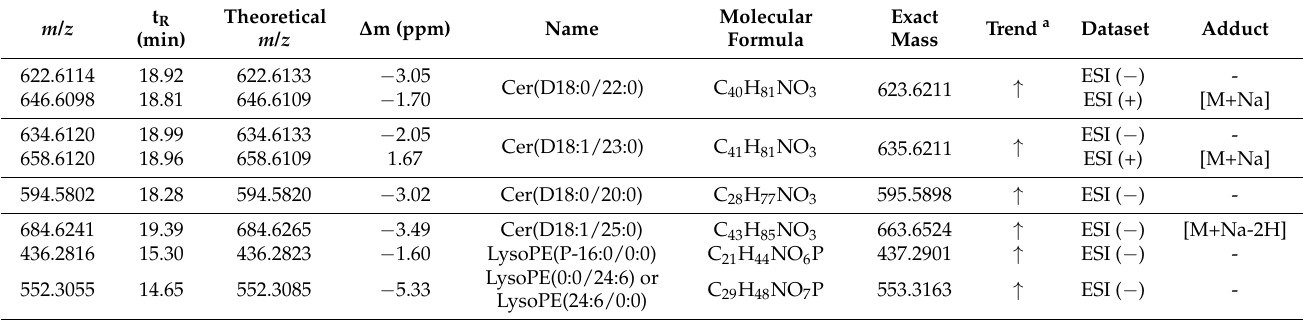
Table 3. Candidate metabolites identified in low and high responders from the plasma-based metabolomic approach obtained from both (+) and ( − ) ESI analyses. The features are presented as a. m / z feature, b. t R (min), c. theoretical m / z , d. ∆ m (ppm), e. possible identification name, f. possible molecular formula, g. corresponding monoisotopic exact mass, h. trend in low responders (up or down regulation), i. dataset (positive or negative ESI mode) and j.